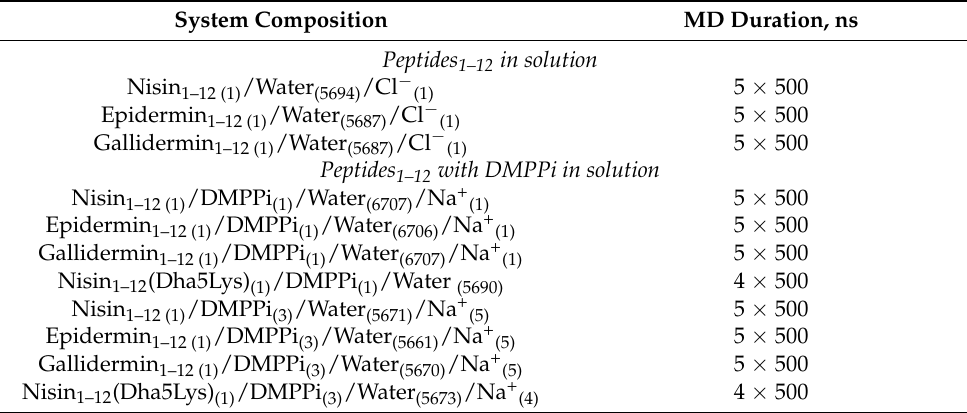
Table 1. MD simulations conducted in this work. Each line is a system composition with a number of entities given in parenthesis and subscript, and MD length with a number of independent replicas. System